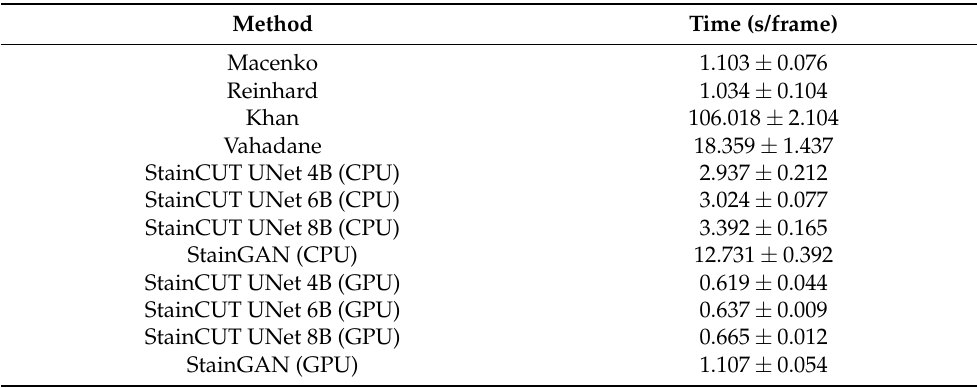
Table 3. Time per frame required by every method (mean the time was measured using either only the CPU or both CPU and GPU. The methods that do not rely on neural networks were executed using only the